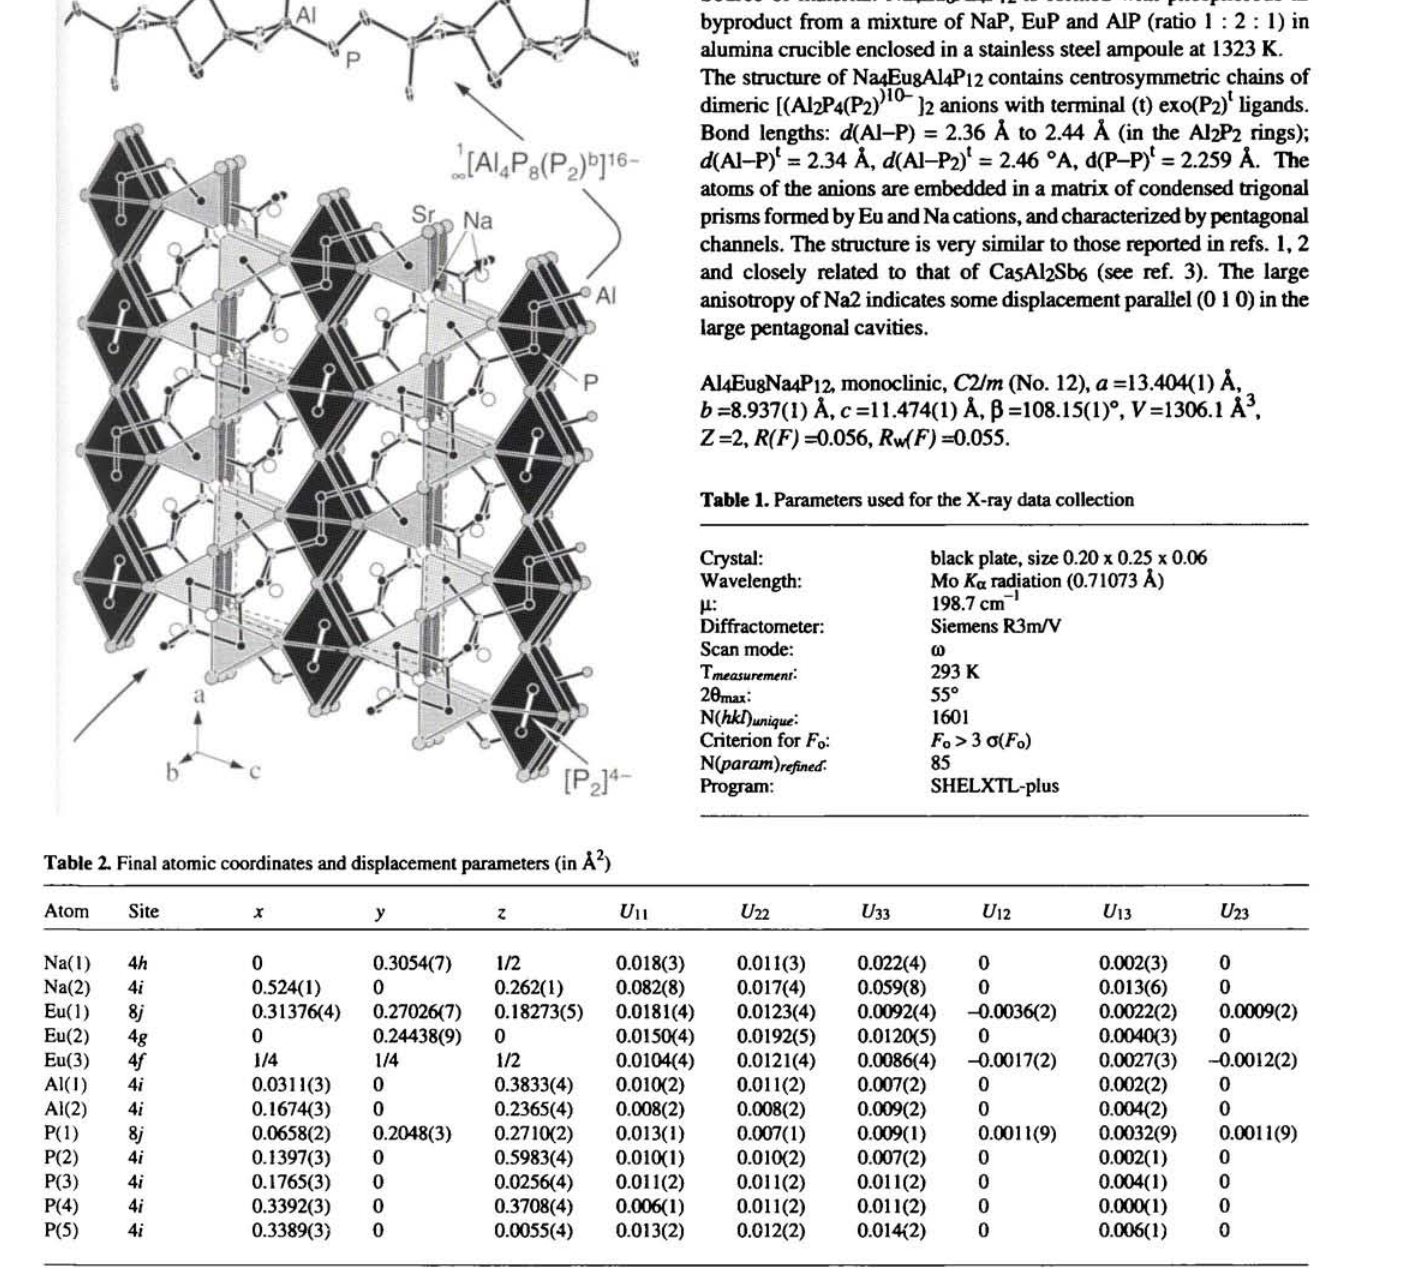
Table 2. Final atomic coordinates and displacement parameters (in Â^)